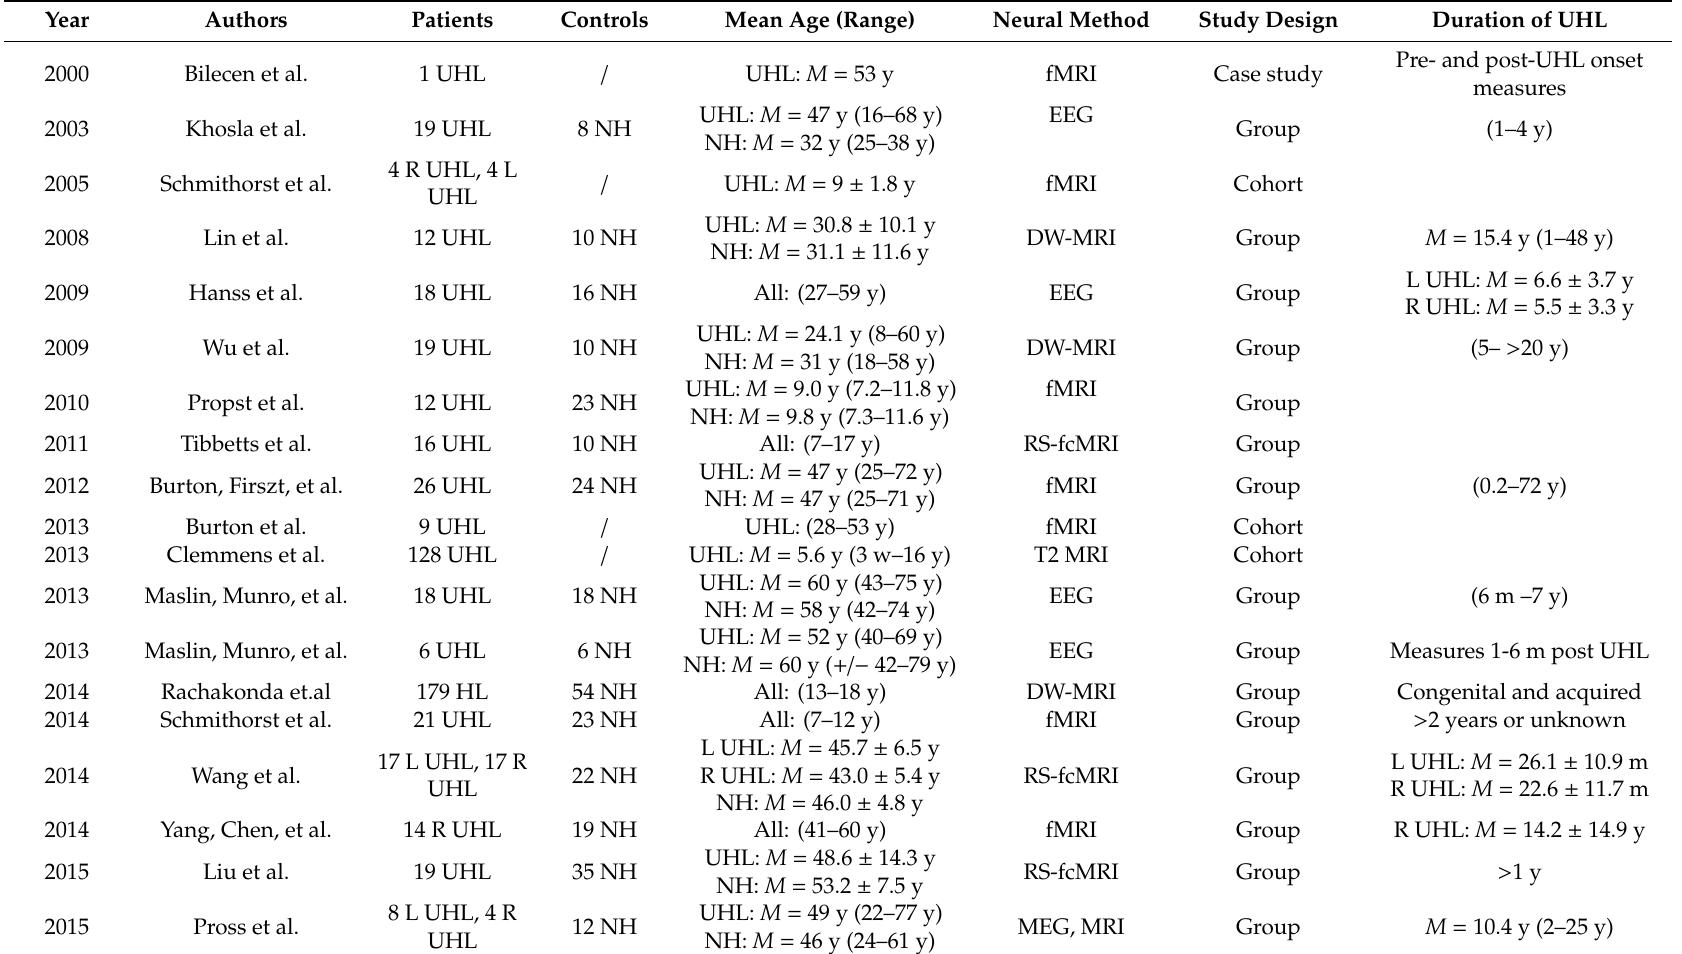
Table 1. List of included articles on patients with unilateral hearing loss